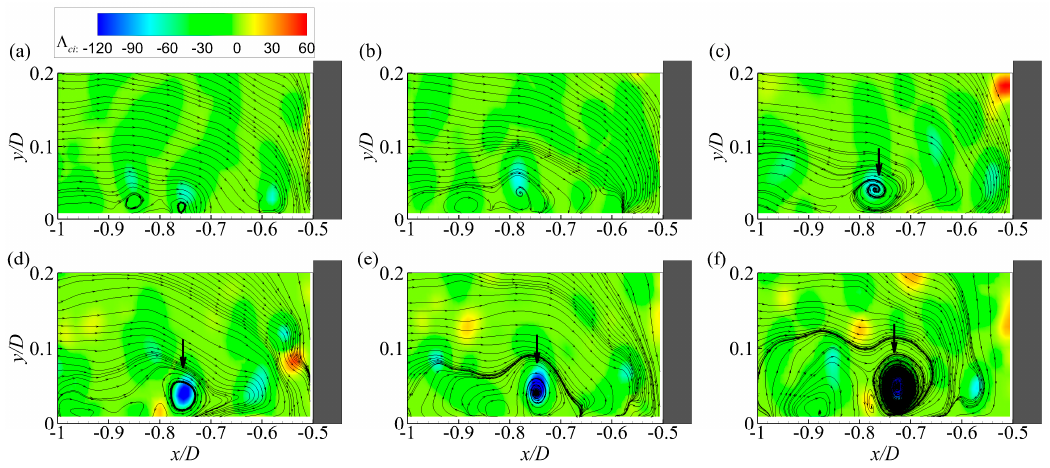
Figure 5. Sequence of instantaneous velocity fields illustrating the generation of a PHV for case C13900. ( a ) t = 0; ( b ) t = 0.29 D / U m ; ( c ) t = 0.58 D / U m ; ( d ) t = 0.87 D / U m ; ( e ) t = 1.13 D / U m ; ( f ) t = 1.40 D / U